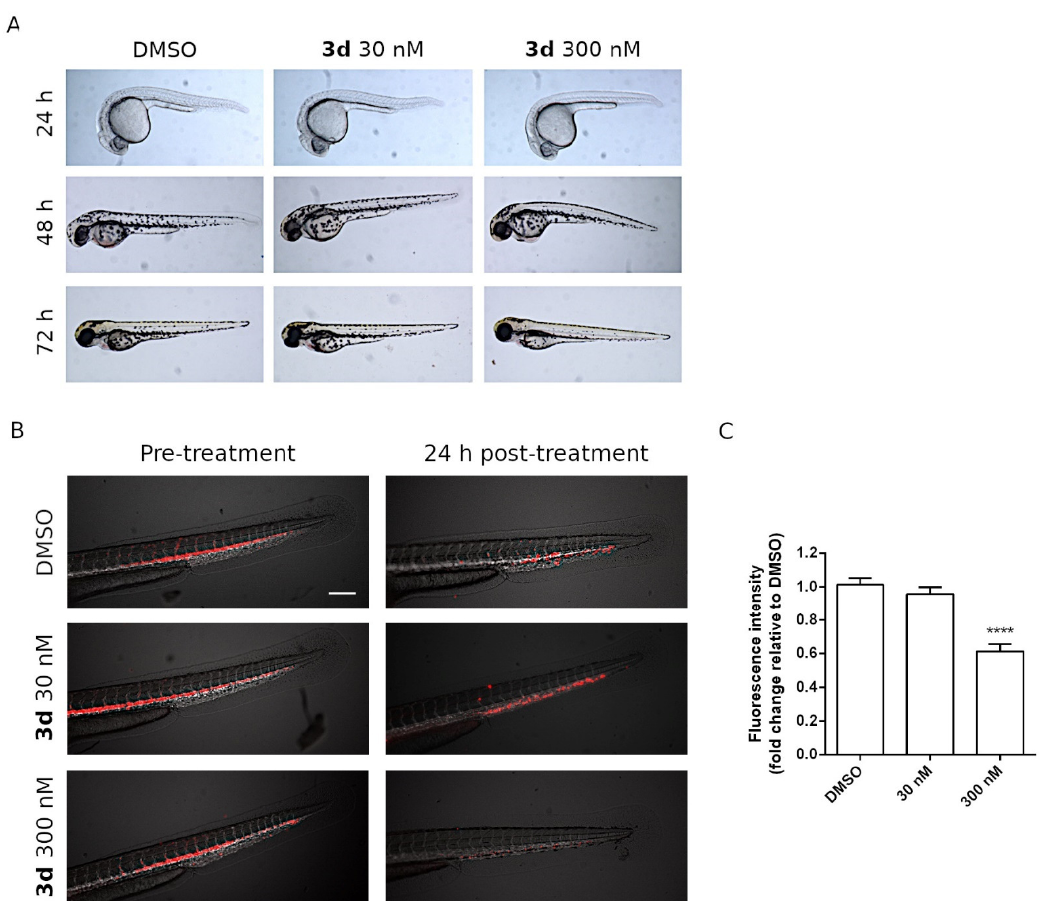
Figure 8. ( A ) Effects of 3d treatment on zebrafish embryos. No abnormal phenotypes or developmental defects were seen in comparison to DMSO-treated embryos (as a normal control) after 24, 48 and 72 h. ( B ) Effects of 3d treatment on the zebrafish xenotransplantation model. Representative images of Tg(fli1:EGFP) zebrafish embryos (blood vessels shown in white) transplanted with DiI + HeLa cells (red). Embryos were treated for 24 h with DMSO (control group), 30 nM 3d or 300 nM 3d . ( C ) Histograms represent the fluorescence intensity of the tumor xenografts, indicating total HeLa cells present in each embryo after a 24 h treatment with 3d at the indicated concentrations. Data are expressed as mean ± SD (**** p < 0.001). Scale bar, 200 µ